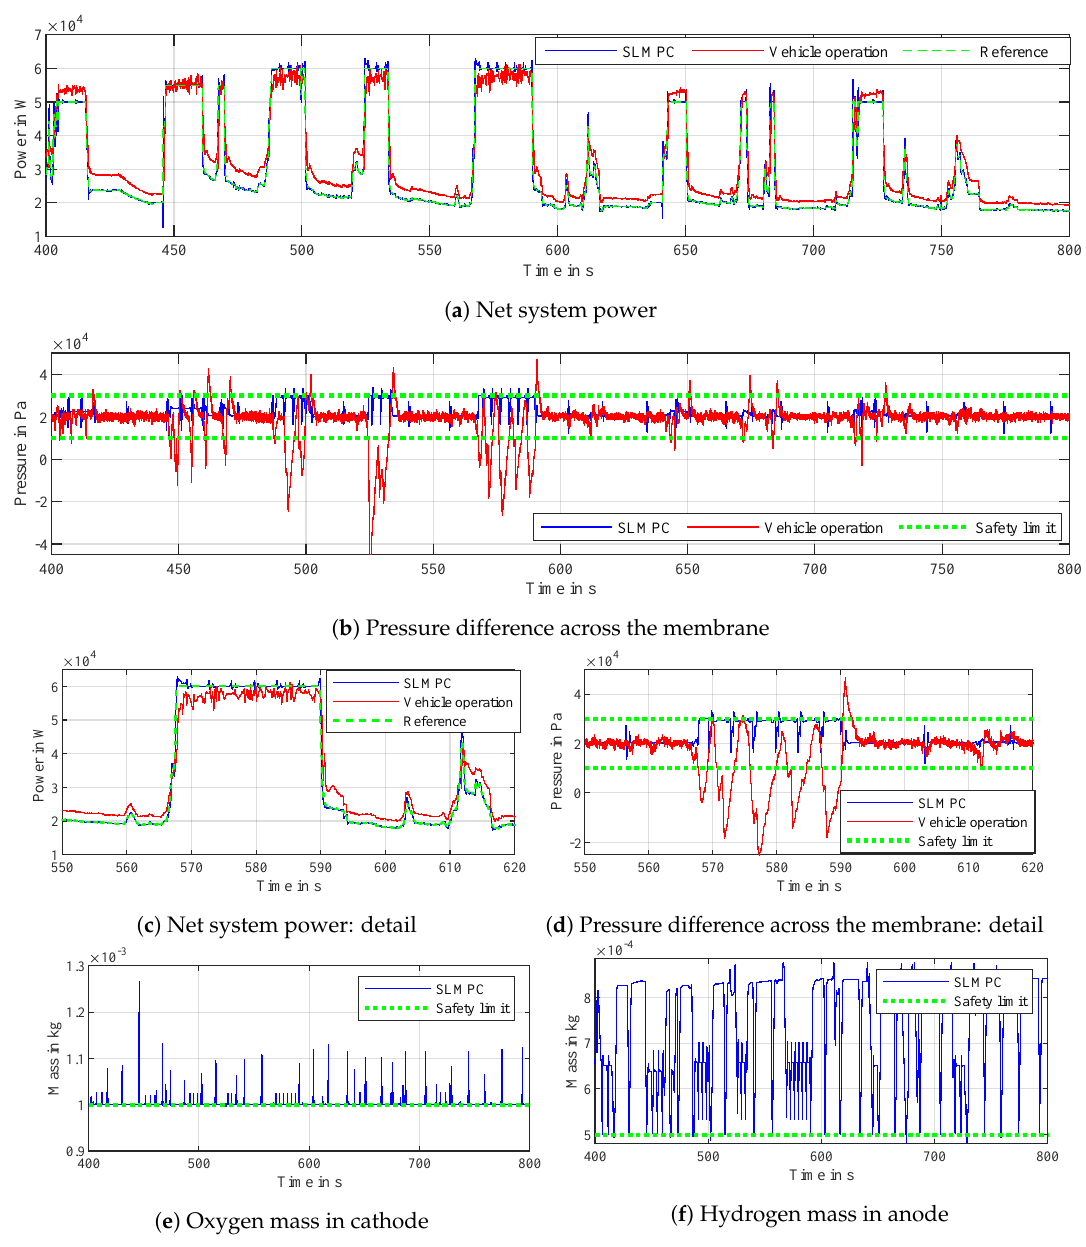
Figure 4. The blue line shows the successive linearization based model predictive control (SLMPC) performance, whereas the red line shows the vehicle operation. In plots ( a , c ) the green line shows the reference power while in plots ( b , d – f ) it shows the safety limit for the presented